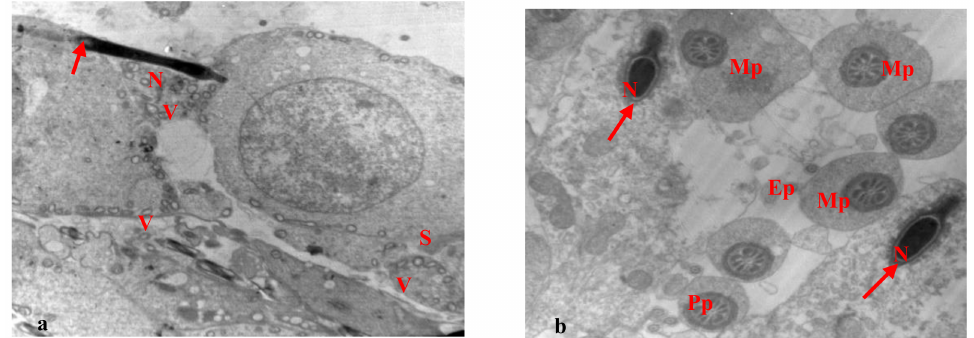
Figure 7. ( a , b ): Electron micrograph of a section of rat’s testis, treated with EVOO for 15 days. ( a ) showing normal seminiferous tubule with normal spermatids (Sd) and a normal nucleus. Sperm appeared with an elongated condensed nucleus (N) and an acrosomal cap (arrow) at the leading point of the head. Notice vacuoles (v) in cells ( × 2000). ( b ) showing that most of the different parts of the sperm flagellum have normal structure, midpiece (Mp), principal piece (Pp), and end piece (Ep), with the typical arrangement of flagellar axoneme. Sperms have normal flagellum and elongated condensed nucleus (N) and an acrosomal cap (arrow) ( × 1500).